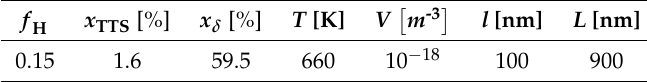
Table 3. Numerical parameters used in the